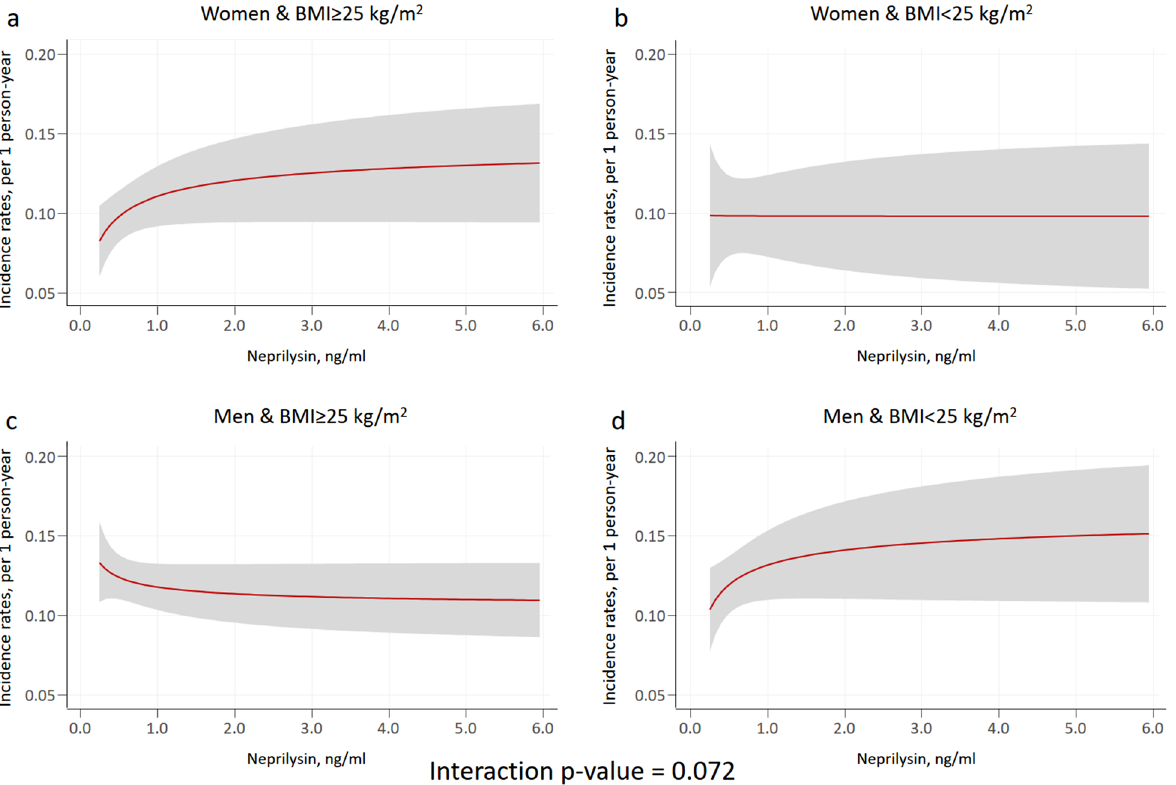
Figure 3. Soluble neprilysin and mortality rates among sex and body mass index categories. Estimates of risk were adjusted for age, HF duration, BMI, NYHA III versus I–II, ischaemic heart disease, systolic blood pressure, heart rate, eGFR, sodium, high-sensitivity troponin T, haemoglobin, ST2, LVEF, and treatment with ACEI/ ARB, beta-blockers, MRA, or loop diuretics. ACEI: angiotensin-converting enzyme inhibitors; ARB: angiotensin II receptor blockers; BMI: body mass index; eGFR: estimated glomerular filtration rate; HF: heart failure; LVEF: left ventricle ejection fraction; MRA: mineralocorticoid receptor antagonist; NYHA: New York Heart Association.